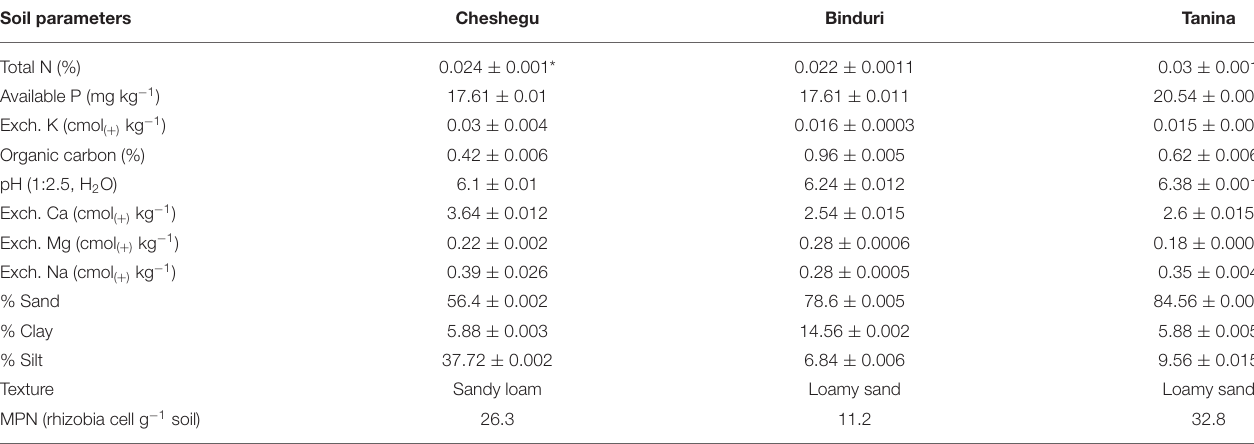
TABLE 1 | Soil physicochemical characteristics and MPN count at the study sites. Soil